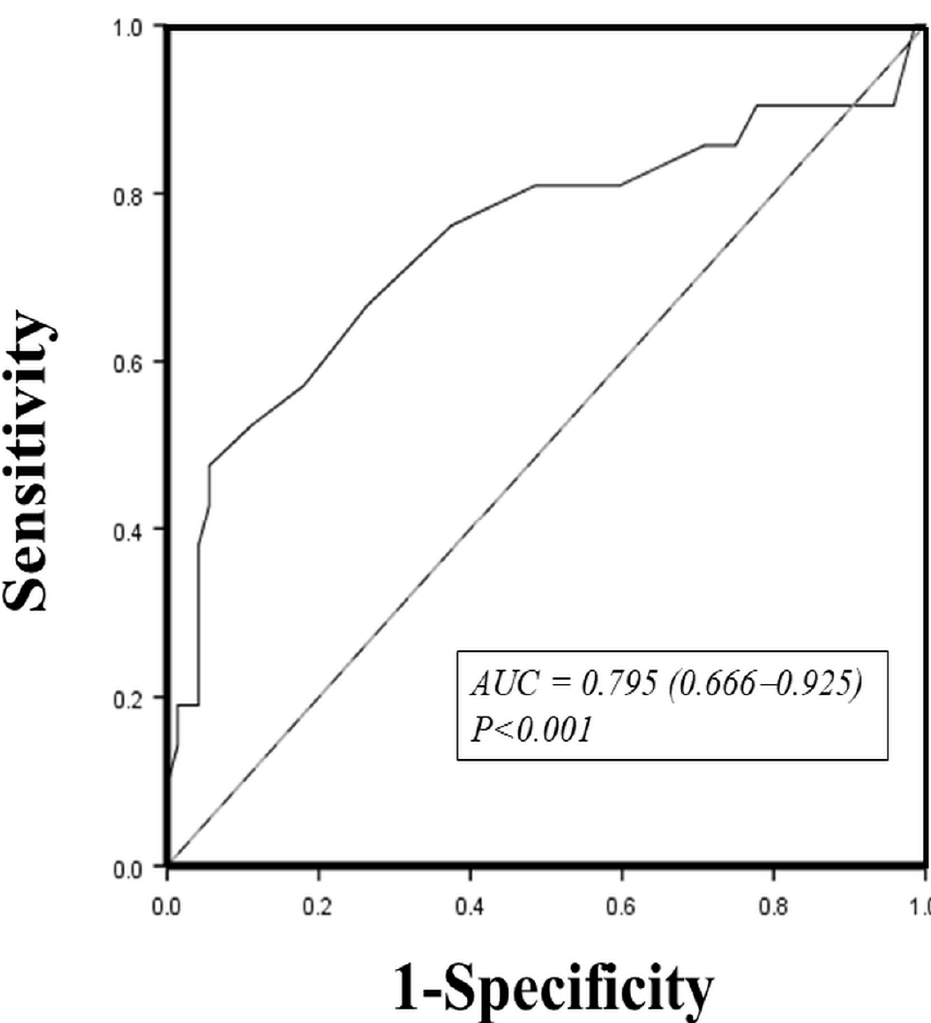
Figure 1. Receiver operating characteristic curve for left atrial size in predicting atrial fibrillation occurrence in patients with obstructive sleep apnea syndrome. AUC: area under the curve. 3.3. mRNA Gene Expression in HL-1 Cells Incubated with Exosomes Derived from OSAS Patients with and without AF The HL-1 cells were incubated with exosomes derived from 80 studied patients with moderate-to-severe OSAS. Among these patients, 21 had AF, and 59 did not. There was no difference in the exosome particle number between OSAS patients with and without AF. OSAS patients with AF occurrence had lower mRNA-level expressions of GJA1 and higher mRNA-level expressions of TNF- α (both p < 0.05) than OSAS patients without AF occurrence (Figure 2). There was no difference in the mRNA expression of HIF-1 α , IL-1 β , IL-6, and TGF- β between OSAS patients with and without AF. After controlling for age and sex, the decreased mRNA-level expression of GJA1 was found to be significantly associated with a higher occurrence of AF in patients with OSAS (r = 0.234, p = 0.039). 3.4. Correlation between GJA1 Gene Expression in HL-1 Cells and PSG Metrics in OSAS Patients with AF To investigate the possible impact of OSAS on GJA1 gene expression in HL-1 cells, we analyzed the correlation between PSG metrics and GJA1 gene expression after controlling for age and sex. We found there was a negative correlation between GJA1 gene expression and AHI during TST (r = − 0.458, p = 0.037), AHI during non-rapid eye movement (NREM) (r = − 0.467, p = 0.033), ODI during TST (r = − 0.459, p = 0.036) and ODI during